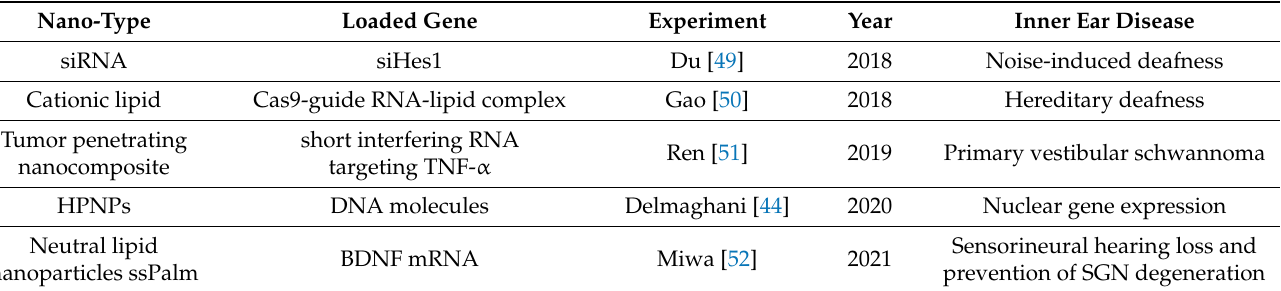
Table 6. The role of nanoparticles in gene